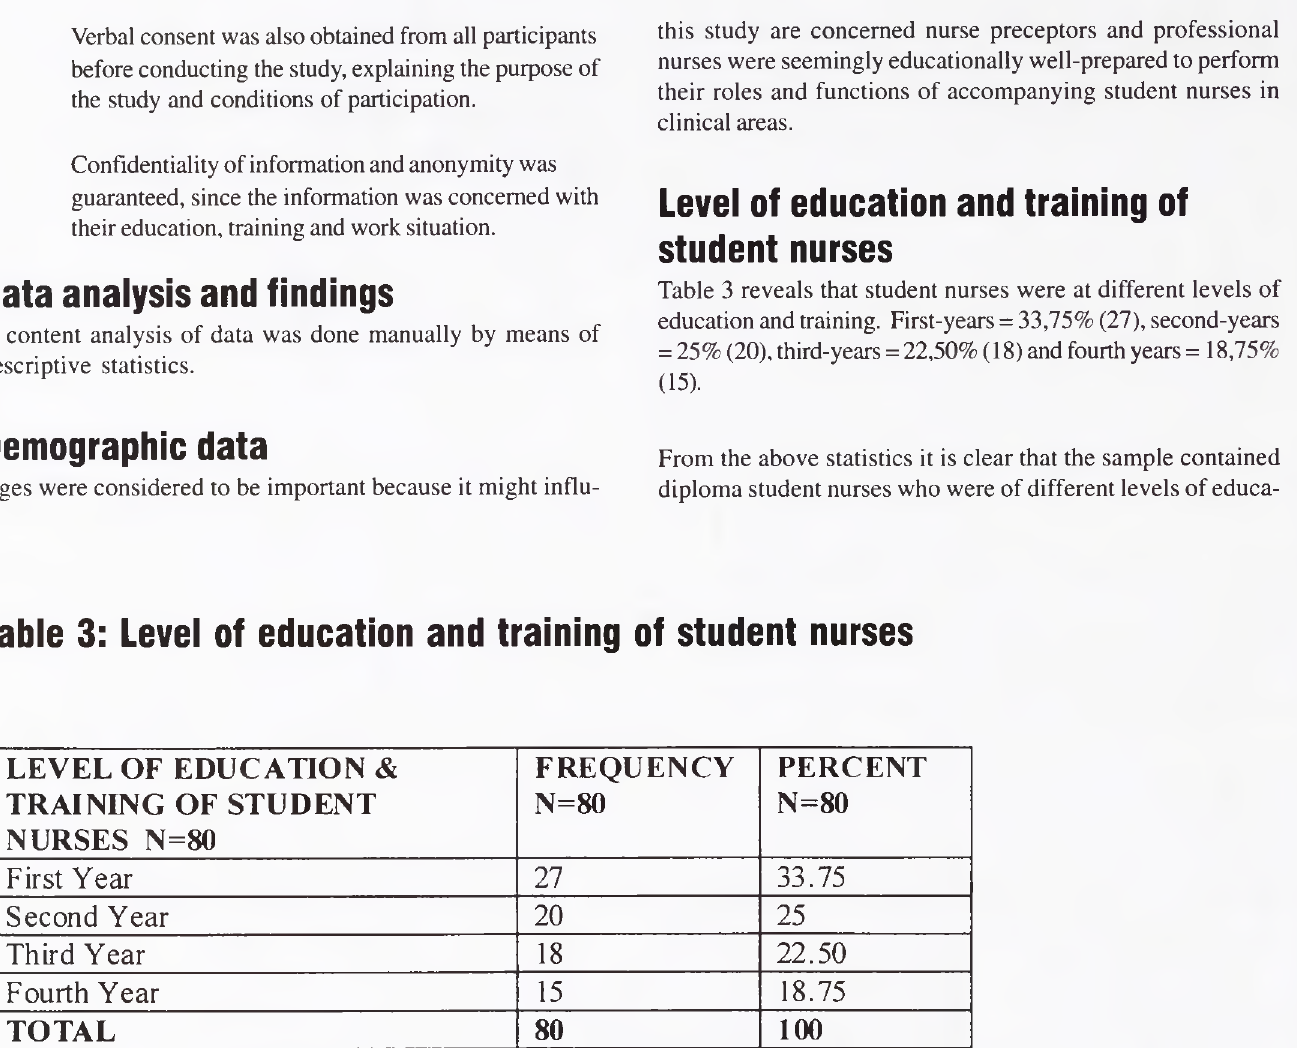
LEVEL OF EDUCATION